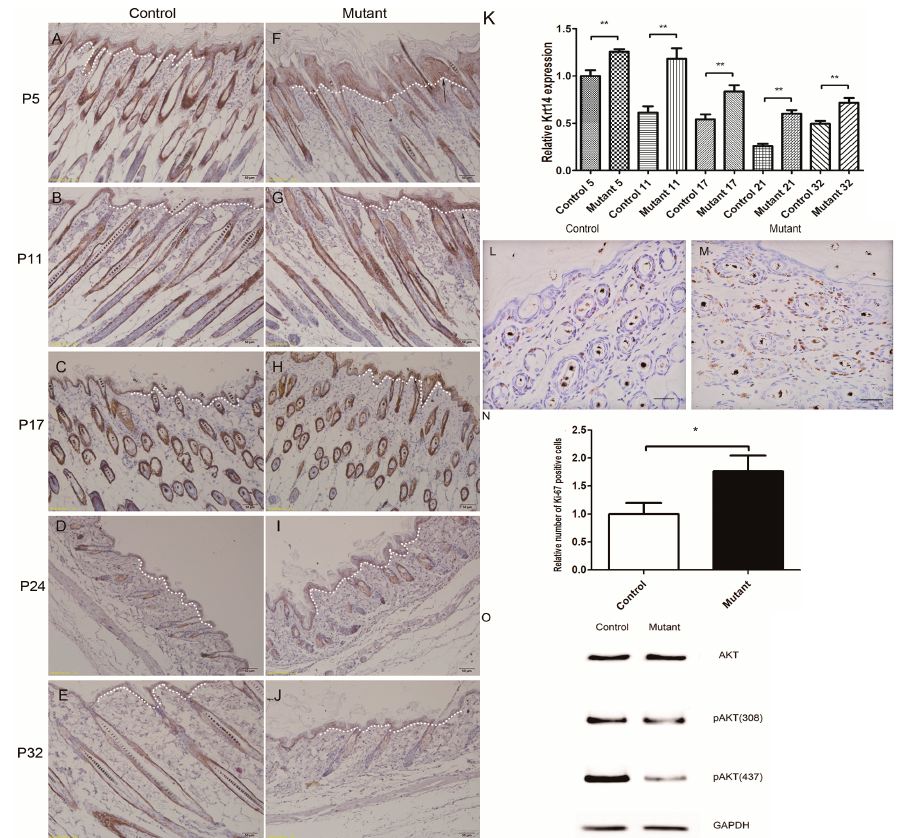
Figure 5. Hyperproliferation of epidermis in Ppp2ca flox/flox ; Krt14-Cre mice and AKT signaling pathway changed. An antibody to Krt14 was used to stain tissue sections from the control ( A – E ) and mutant ( F – J ) dorsal skin at the follicular morphogenesis (P5; panels A and F ), anagen (P11; panels B and G ), catagen (P17; panels C and H ), telogen (P24; panels D and I ), and anagen (P32; panels E and J ) phases. Arrows indicate a conspicuously higher number of Krt14-positive cells in the skin of mutant mice than in the epidermis of the control mice (panels A – J ). All scale bars = 50 μ m; ( L , M ) Ki67 antibody staining showed hyperproliferation in the epidermis of eight-week mutant mice epidermis compared to control littermates. All scale bars = 20 μ m; ( K , N ) Statistical analysis indicated that the expression of Krt14 in mice skin was significantly increased at all stage. Statistical analysis indicated that the Ki67 positive cells were increased in mutant mice epidermis. n = 3 in each group, * p < 0.1, ** p < 0.01; ( O ) Western blot analysis of AKT, pAKT (S473), pAKT (T308), from mouse epidermis protein extracts from the knockout group and the control group. The Krt14-positive cell area was indicated by white dotted lines.